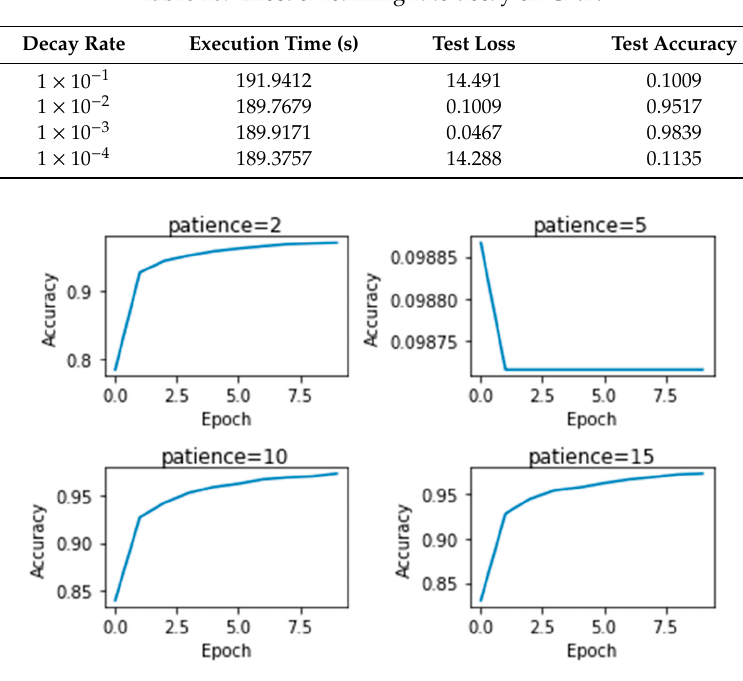
Table 7. Architecture of base and knowledge-transfer model.